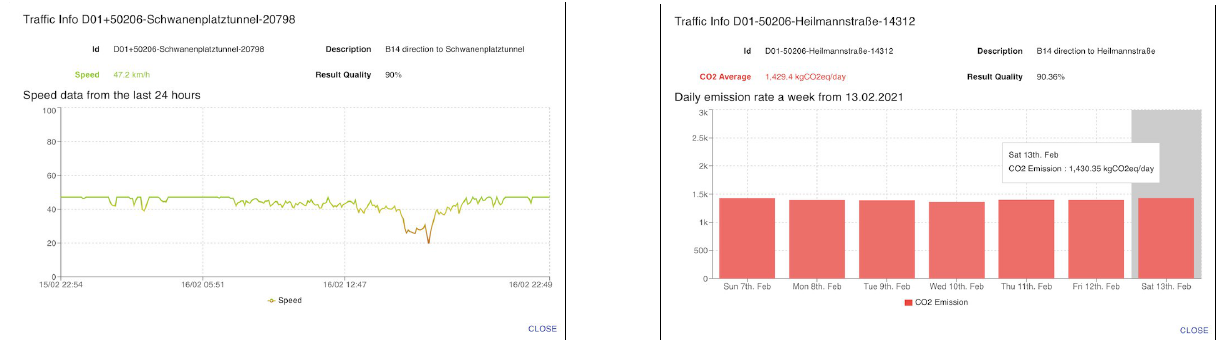
Figure 5. Information popup for a road feature according to the chosen theme traffic speed and CO 2